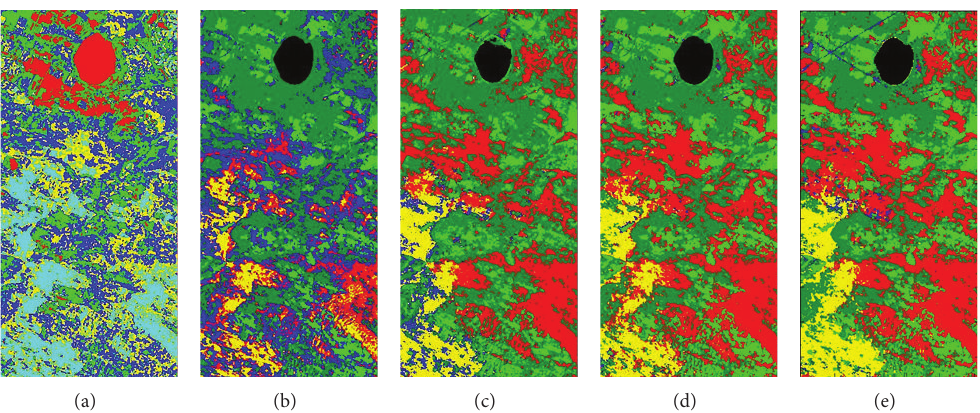
Figure 5: The classification results of study area using various classifier methods. (a) The classified image using 𝐾 -means classifier method. (b) The classified image using minimum distance classifier method. (c) The classified image using artificial neural network classifier method. (d) The classified image using support vector machine classifier method. (e) The classified image using the semisupervised classifier of the proposed method in this paper.